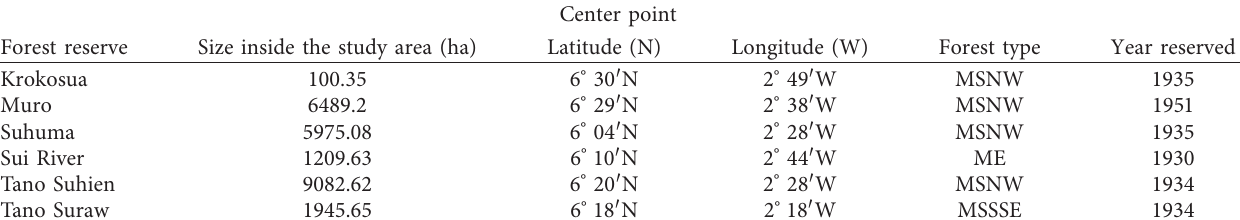
(Table 3) for false color composites in Landsat 5 and Landsat 7 images were used to identify various land cover within the study area for better classification results [27].